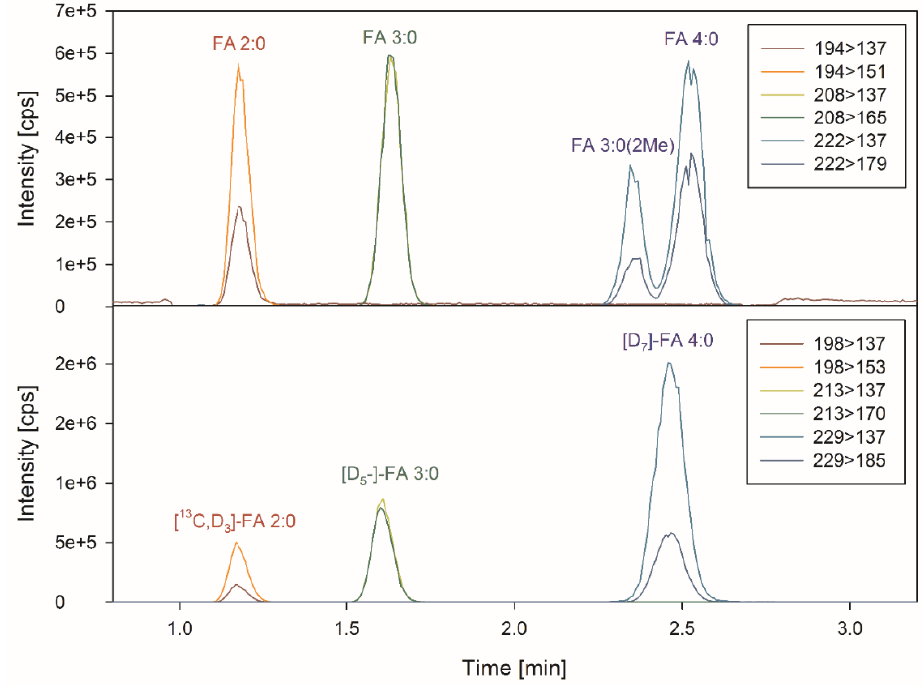
Figure 1. Chromatogram of short chain fatty acids (SCFAs) and their internal standards. Displayed are the extracted ion chromatograms of SCFAs, and their internal standards of a representative human fecal sample.